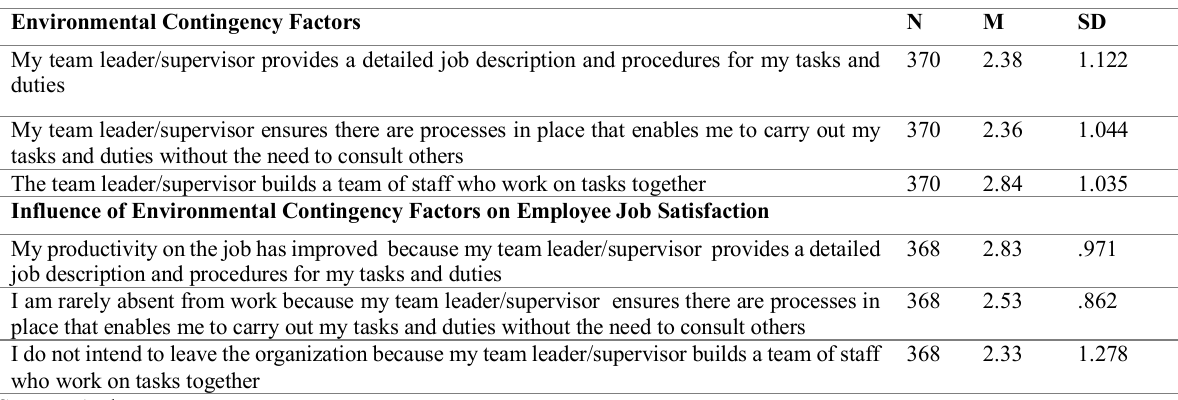
Table 11: Mean and standard deviation for environmental contingency factors